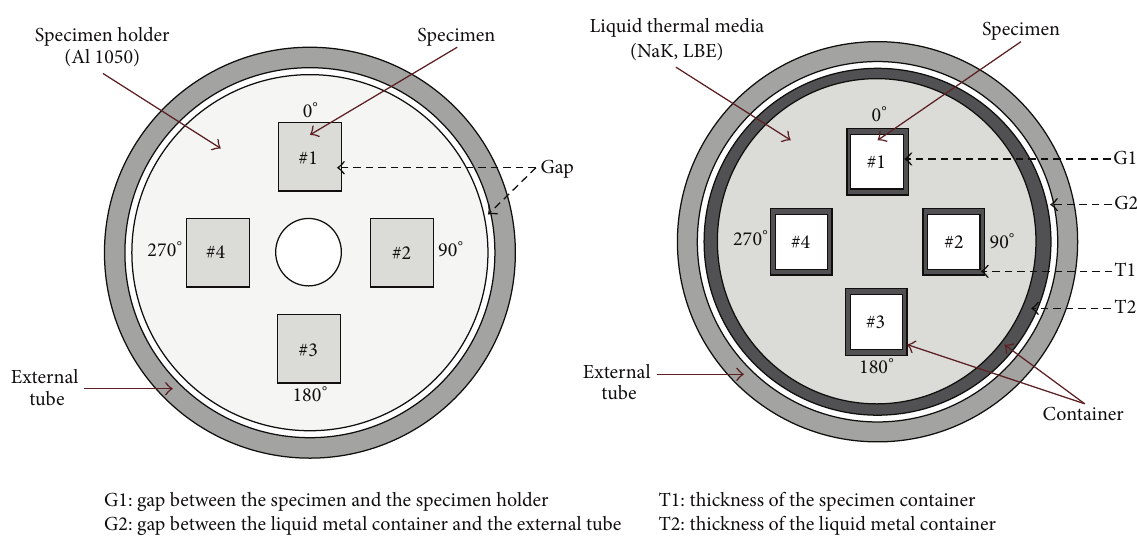
Figure 3: Cross sections of capsules with solid and liquid thermal